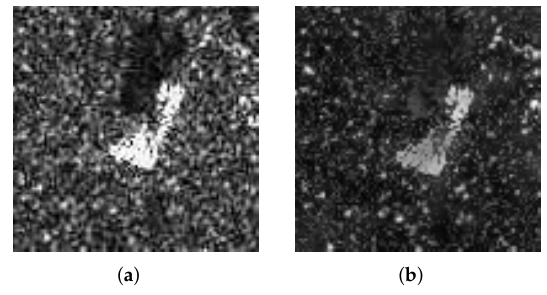
Figure 4. The saliency map generation process of an image.